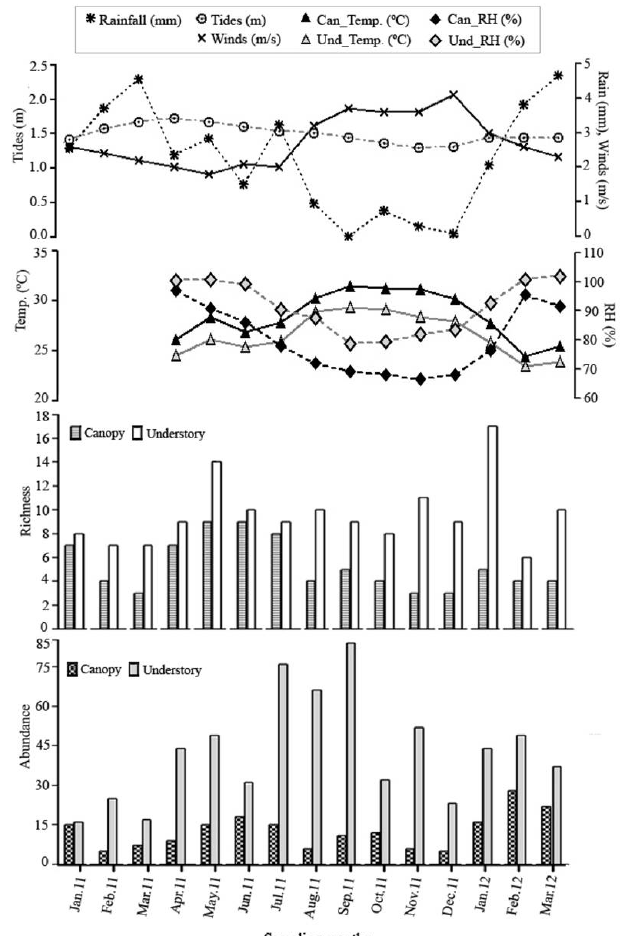
Fig 1 . Monthly fluctuation of abiotic variables, abundance and richness of male euglossine bees sampled in canopy (25 m) and understory (1.5 m) of Amazon várzea floodplain forest. Can_Temp. (ºC) = mean temperature (ºC) in canopy; Und_ Temp. (ºC) = mean temperature (ºC) in understory; Can_RH (%) = relative humidity (%) in canopy; Und_ RH (%) = relative humidity (%) in understory. Obs.: Rainfall (mm) values divided by 100 to fit of